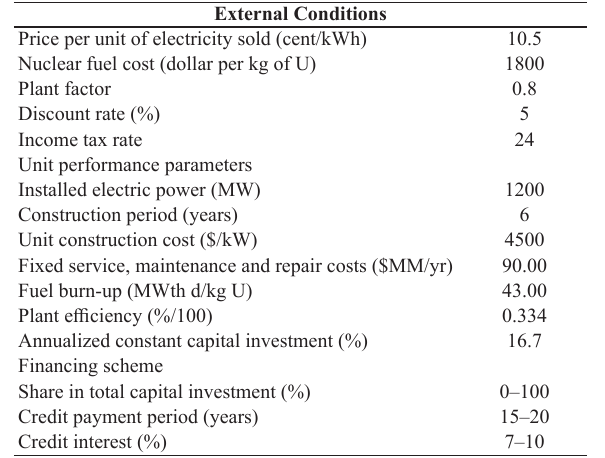
Table 2. Initial data.